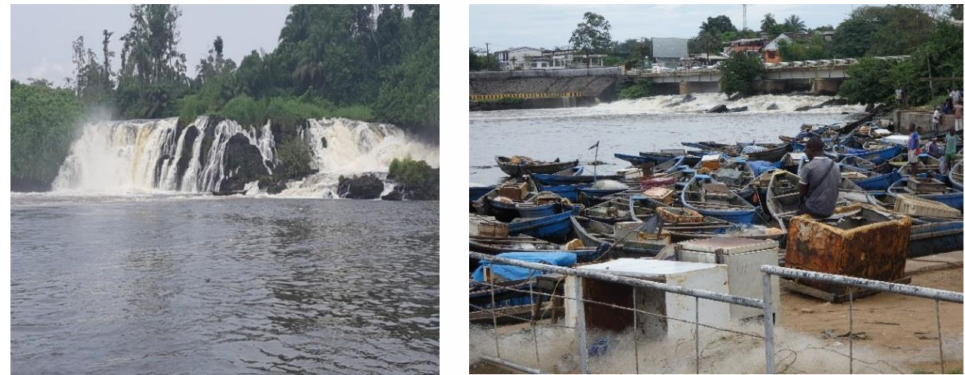
Figure 5. The Lob é waterfalls, Kribi coast, and the Kienk é flowing to the sea by small waterfalls under the bridge at the Kribi landing stage (Credit: Mbevo, August 2018 and Tchindjang, July